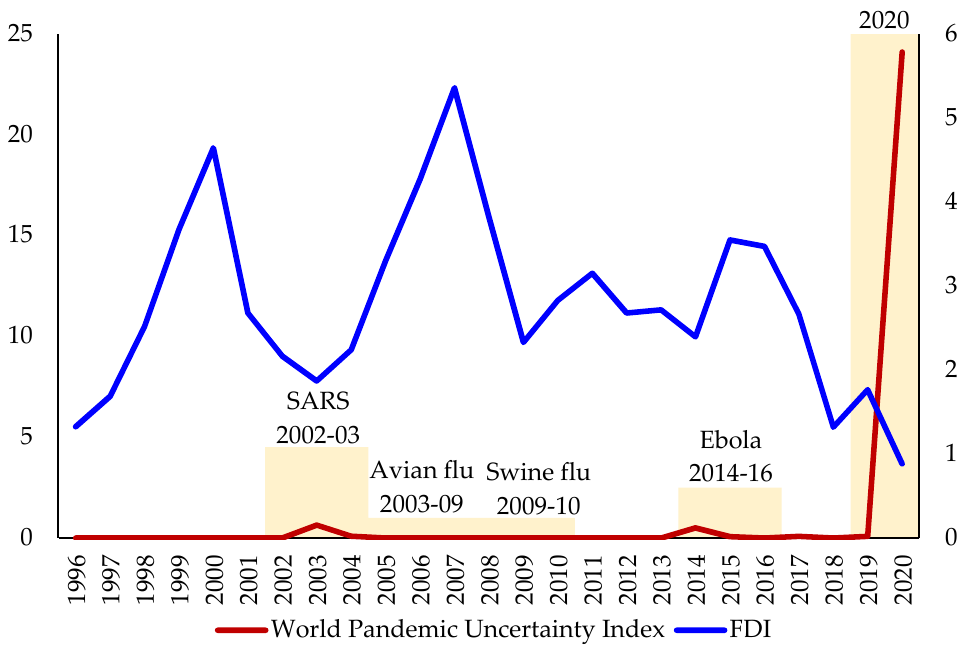
Figure 1. World Pandemic Uncertainty Index and FDI. Source: Authors’ calculation based on Ahir et al. (2018), WPUI (2020), the Organisation for Economic Co-operation and Development (OECD 2020b), and the World Bank’s World Development Indicators (WB-WDI) at https://databank.worldbank.org/source/world-development-indicators (accessed on 8 January 2021). Note: The World Pandemic Uncertainty Index is the aggregate WPUI worldwide as the simple average of 143 countries (Ahir et al. 2018; WPUI 2020). FDI (the right axis) is the world FDI net inflows as a percentage of GDP from the WB-WDI. FDI in 2020 is computed based on data in 2019 using the prediction of a 50% fall by OECD (2020b).